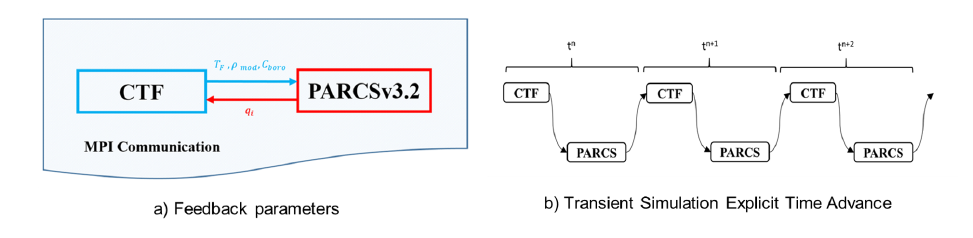
Figure 4. CTF-PARCS external coupling using a client/server MPI Coupling Interface.